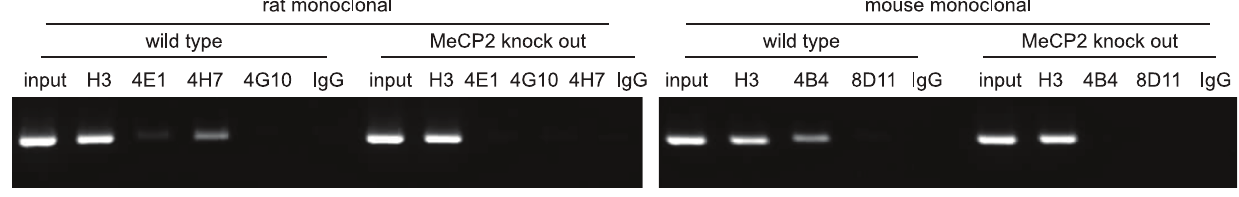
Figure 5. Chromatin immunoprecipitation. Chromatin immunoprecipitation assays were performed using mouse brain nuclear extracts obtained from wild type mice and MeCP2 knock out (KO) mice as negative control. The anti histone H3 antibody was used as a positive control of chromatin immunoprecipitation assay efficiency. IgG was used as a negative control of chromatin immunoprecipitation.